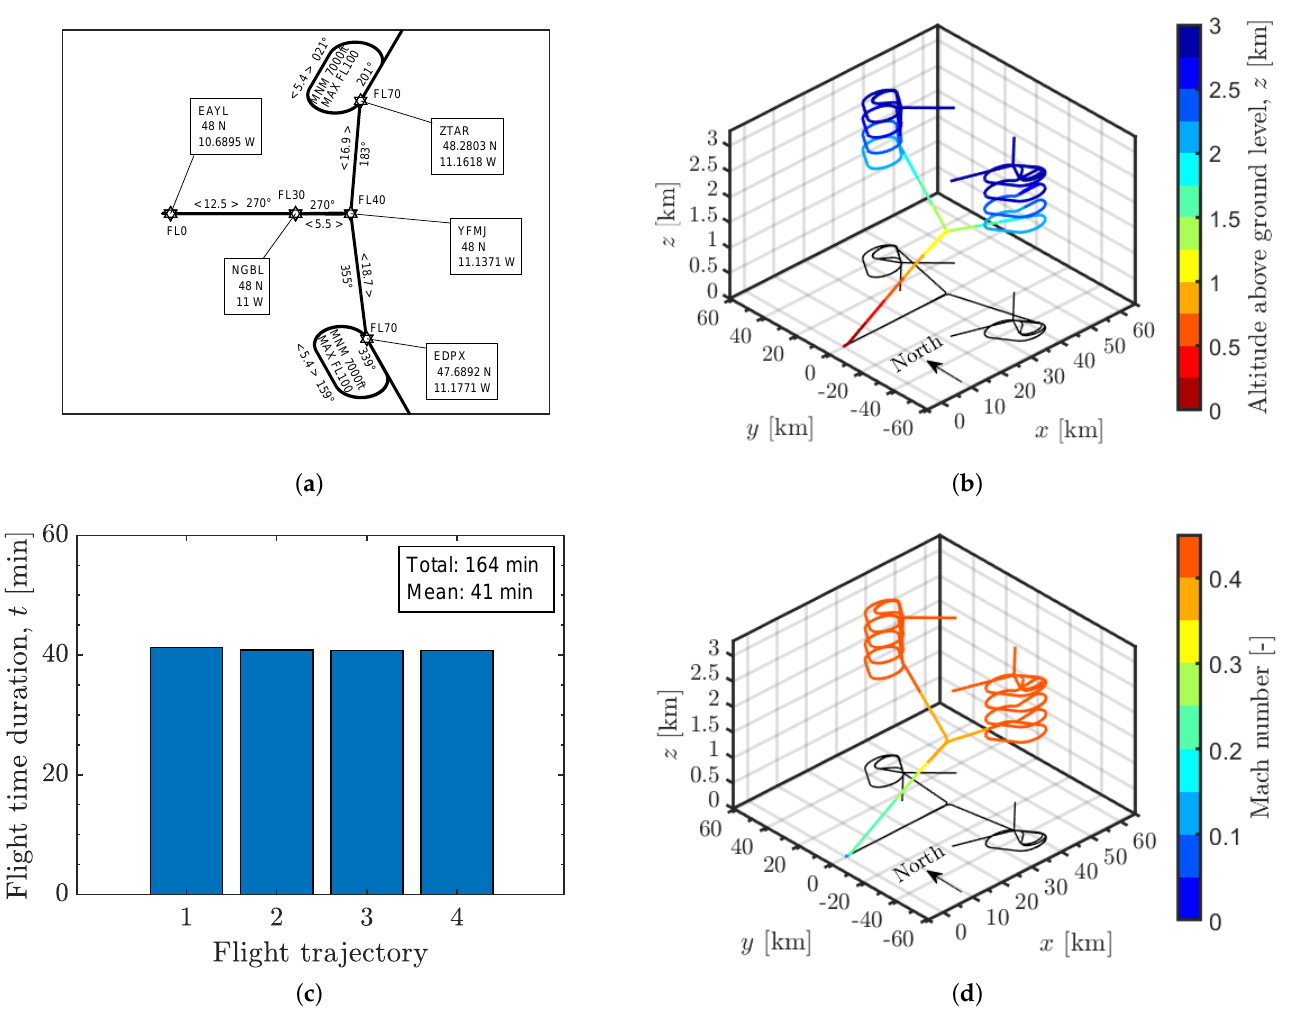
Figure 3. Air traffic scenario considering the vertical holding stack concept: ( a ) flight chart, ( b ) altitude profiles of the flight trajectories, ( c ) total flight time duration per flight trajectory, and ( d ) velocity profiles of the flight trajectories. For the sake of clarity, only flight trajectories calculated based on the performance of an Airbus A320 are